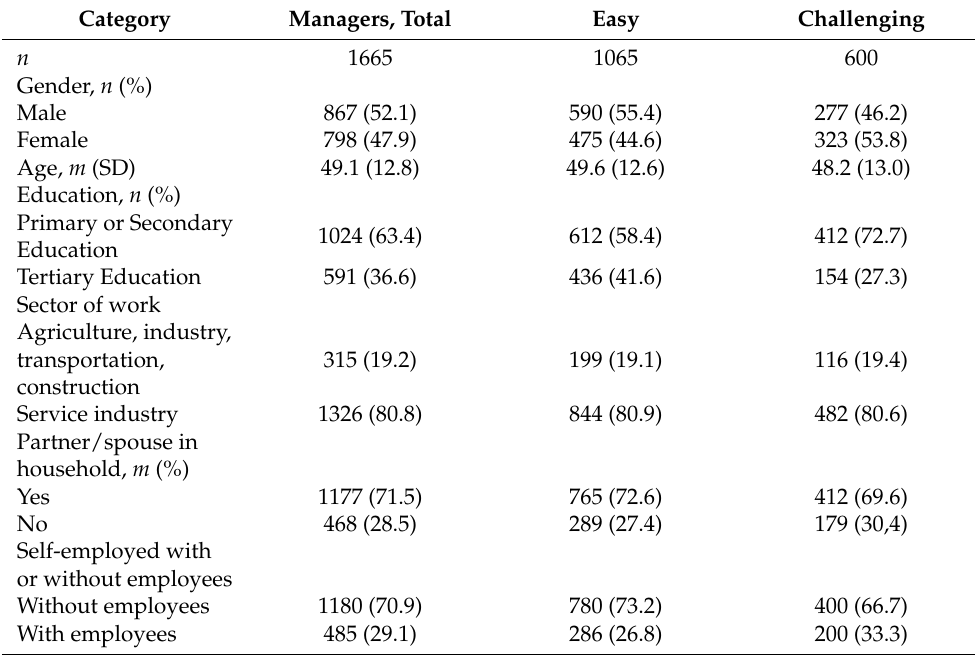
Table 1. Descriptive data for the study population ( N =